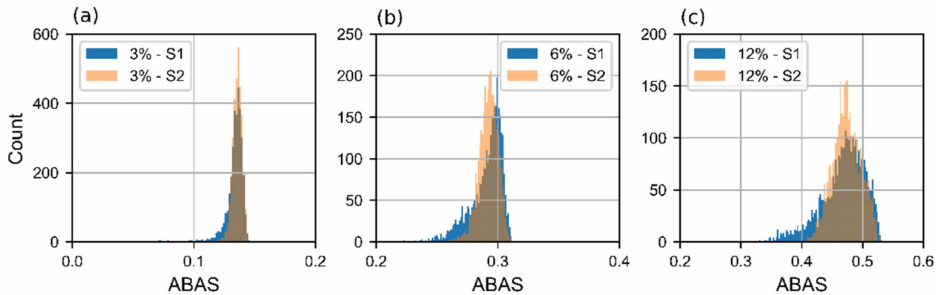
Figure 10. Distribution of ABAS scores for the 3D toy examples having a single defect in both sensor configurations for ( a ) 3%, ( b ) 6%, and ( c ) 12% defect sizes.